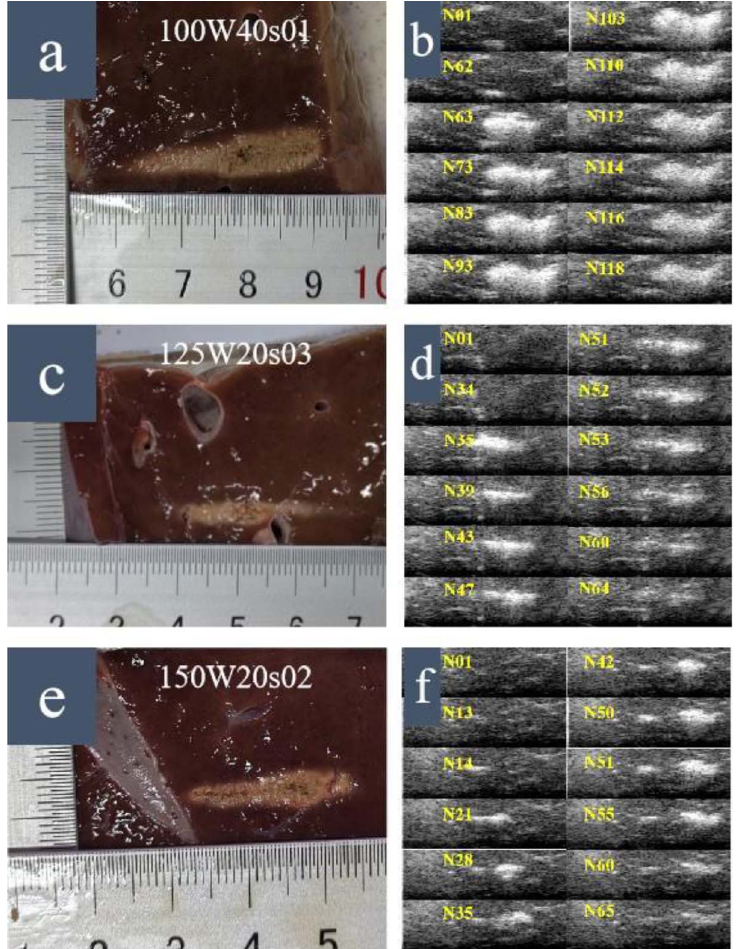
Figure 8. Thermal damage slices and B-ultrasound images (a) and (b) 100W40s, (c) and (d) 125W20s, (e) and (f)